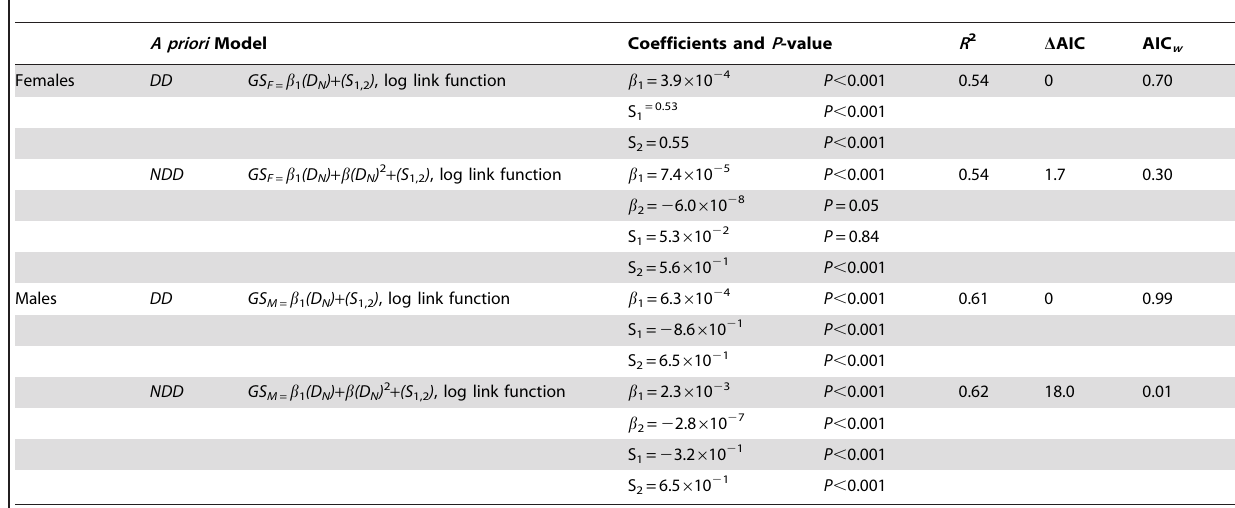
Table 2. Comparison of density – ( DD ), and negative density–dependent ( NDD ) response to unadjusted group size GS ð Þ for female ( F ) and ( M ) elk to population size ( D N ) by season ( S 1,2 ) 1 in Riding Mountain National Park over six years (2002–2004, 2007– 2009) during an intentional population reduction.